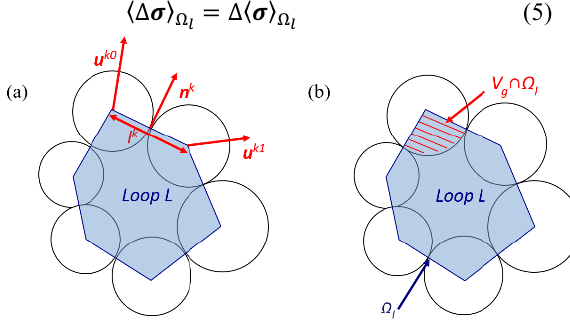
Fig. 3. Sketches to illustrate the calculation of the meso-strain (a) and meso-stress (b).